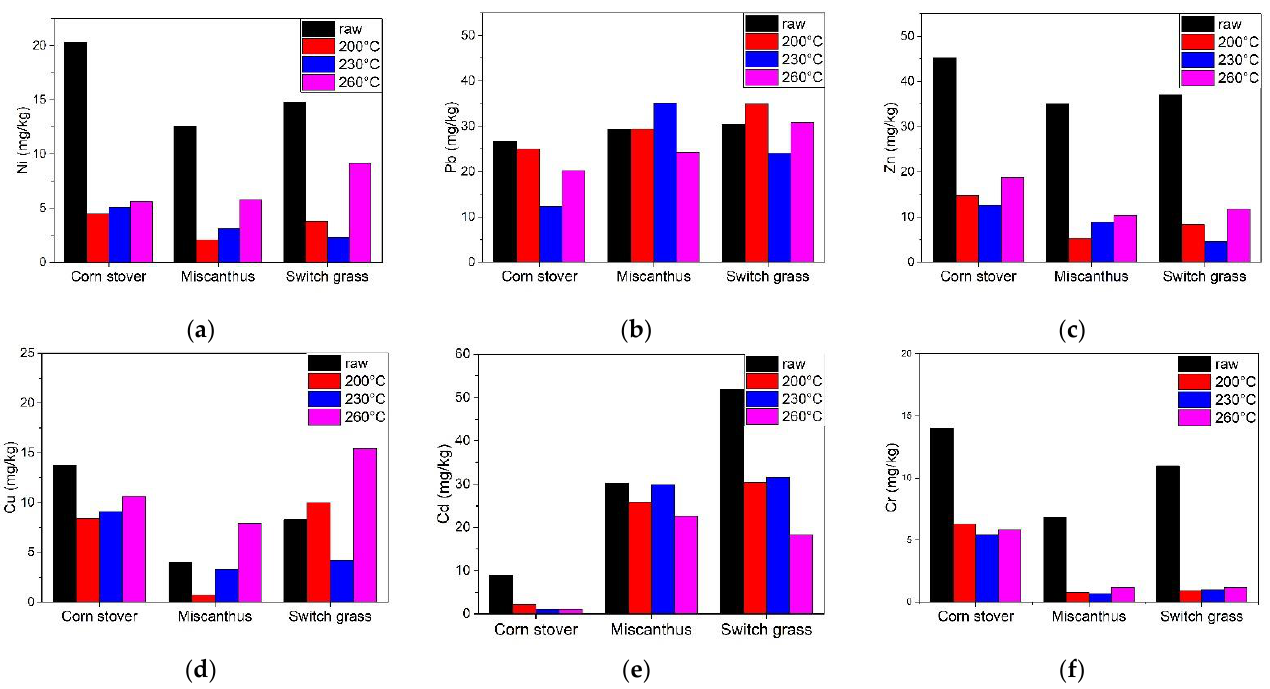
Figure 4. The amounts of heavy metals removed from 1 kg biowaste sources. Ni ( a ); Pb ( b ); Zn ( c ); Cu ( d ); Cd ( e ); and Cr ( f ) (adapted from [148]).